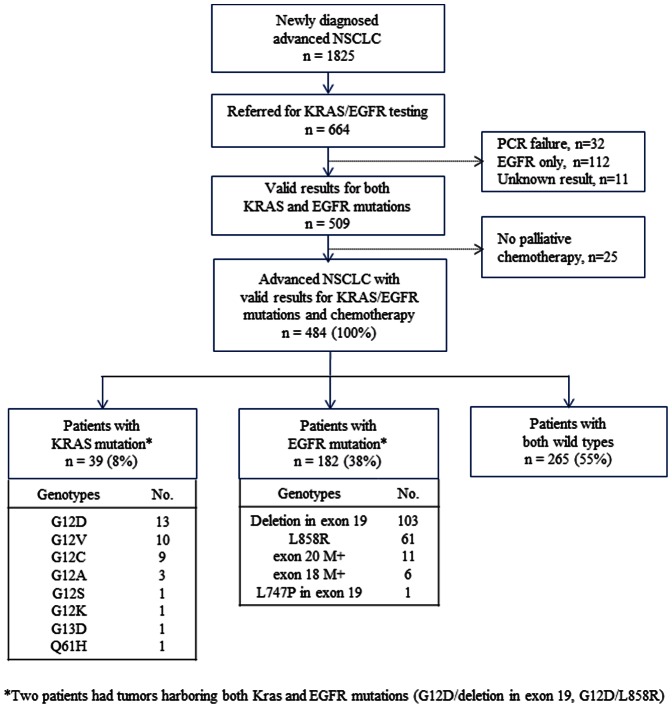
Flow chart of study population.In total, 484 patients with advanced NSCLC with valid results for both KRAS/EGFR mutation status and chemotherapy were included. There were 39 KRAS mutations, 182 EGFR mutations, 265 both wild types. Interestingly, two patients had tumors simultaneously harboring both KRAS and EGFR mutations.